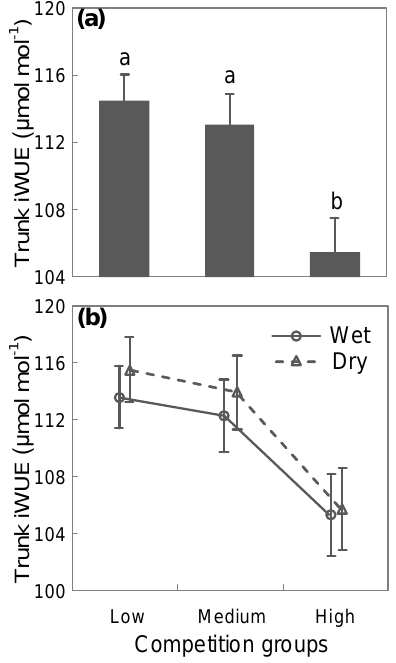
Figure 4. Average trunk iWUE (SE) of di ff erent competition groups ( n = 3, 3, and 3) for ( a ) all years (1955–2015), ( b ) 31 years with precipitation < average (dry years) and 30 years with precipitation > average (wet years). Di ff erent letters indicate significant di ff erences ( p < 0.05) among tree competition groups. In dry years, the di ff erence between low competition-level trees and high competition-level trees was significant at 90% confidence level ( p = 0.083); in wet years, there was a significant di ff erence between low and high competition-level trees at the 75% confidence level ( p =